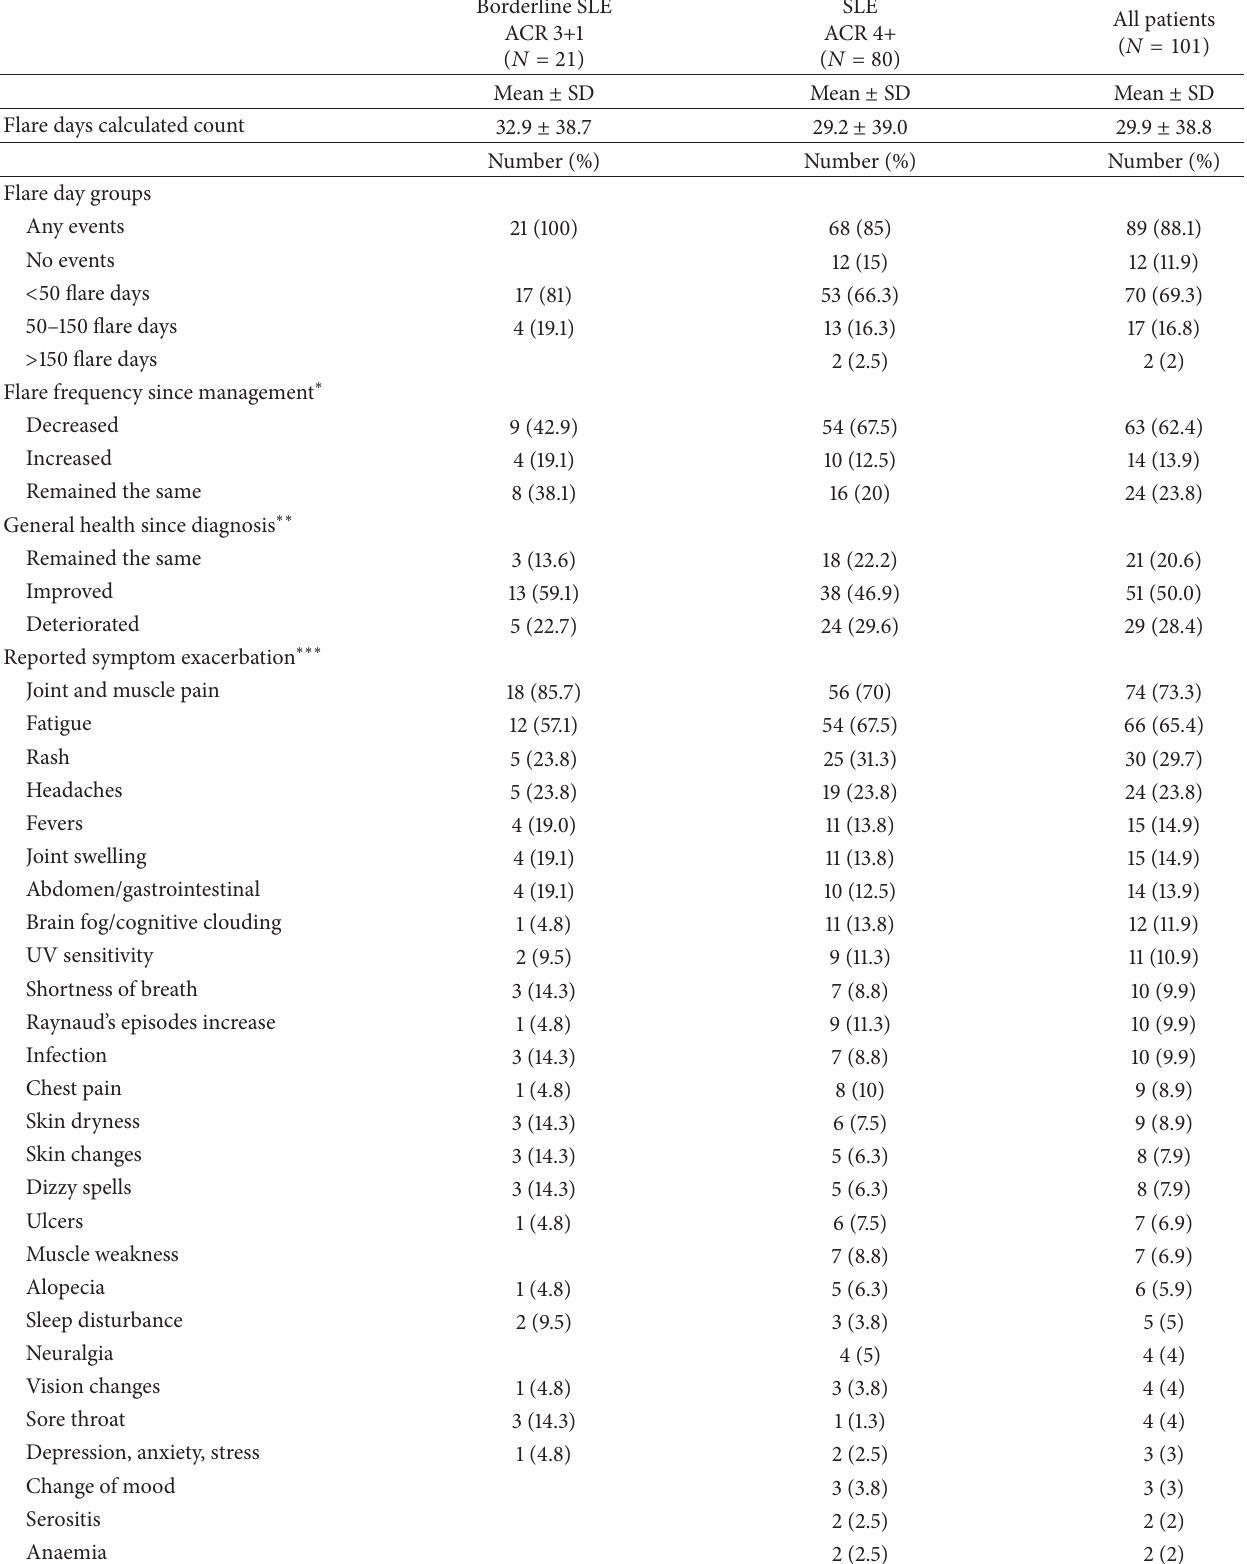
Table 2: Patient reported flare frequency and